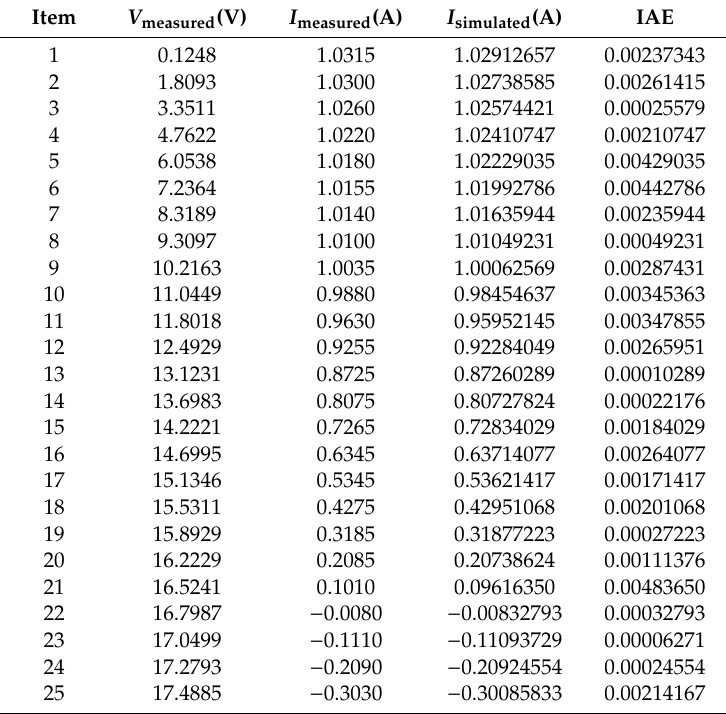
Table A4. Absolute error of IMFO for each measured on the PV module model.